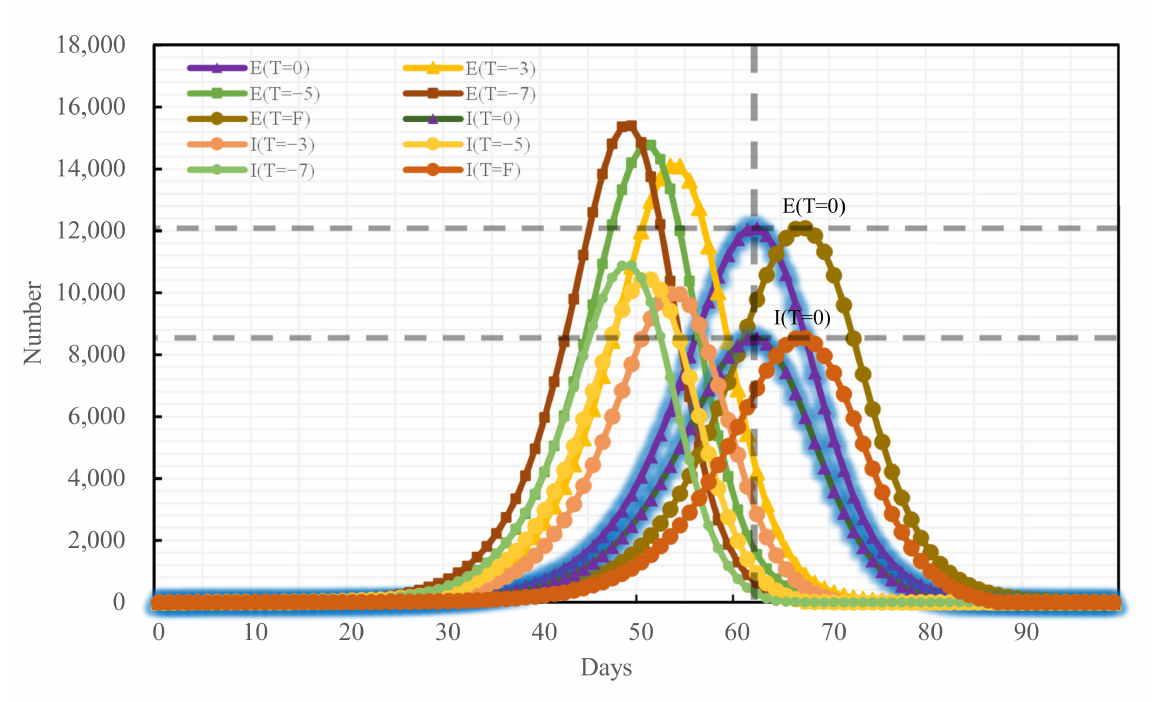
Figure 11. Epidemic trend under the public transport suspension policy promulgated at distinct time